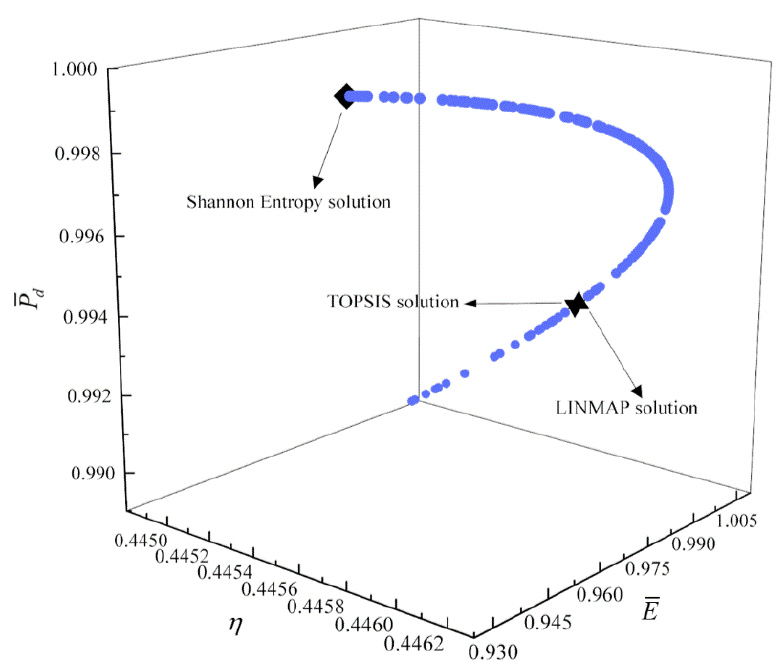
Figure 13. Tri-objective optimization on P